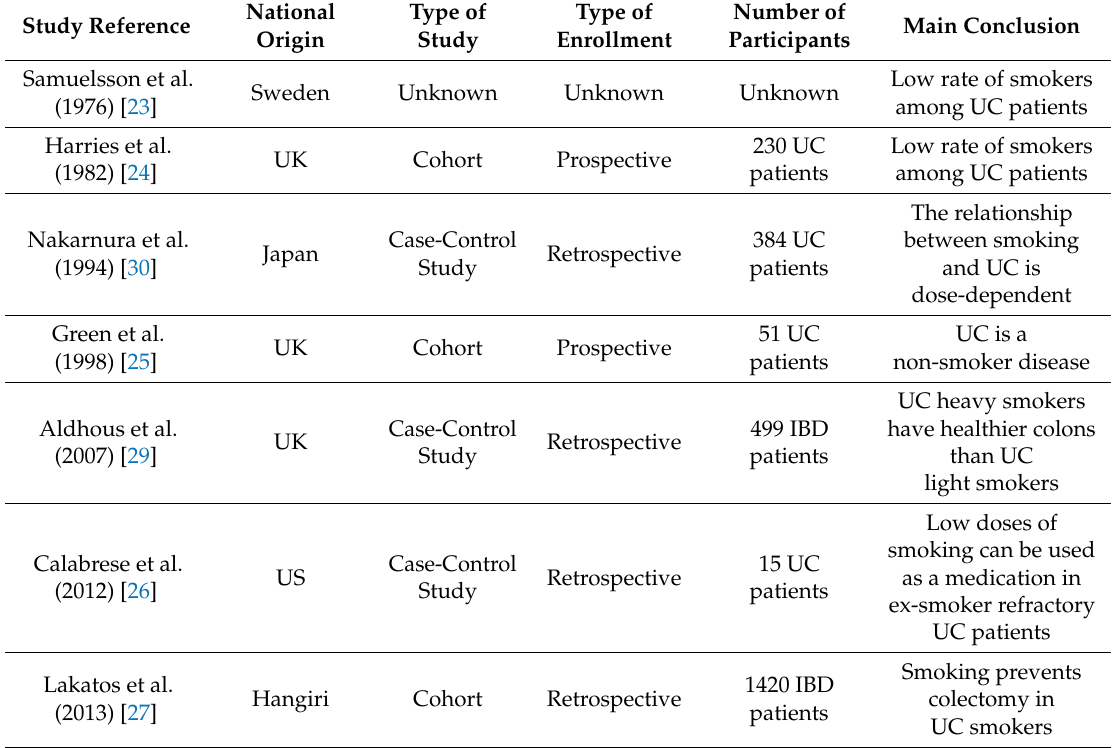
Table 2. List of clinical studies investigating the e ff ect of smoking on UC